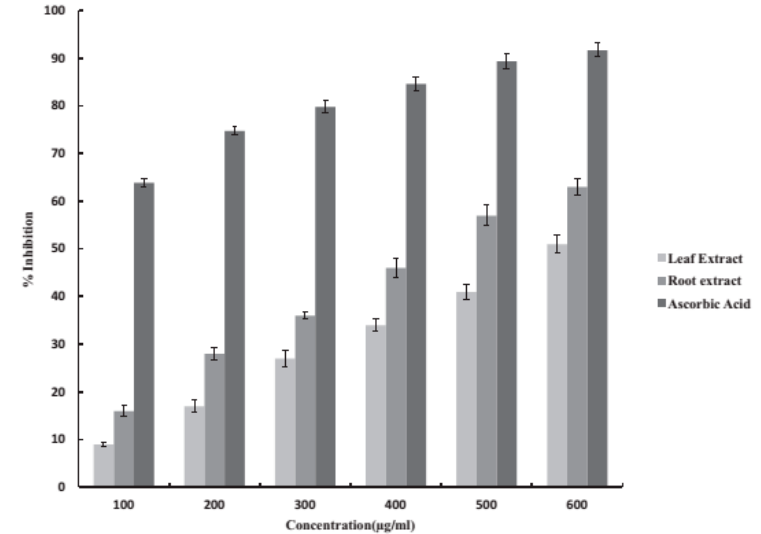
Figure 4. Superoxide scavenging activity of methnolic extracts of leaves and roots of G. kurroo Royle (Source: [59]).